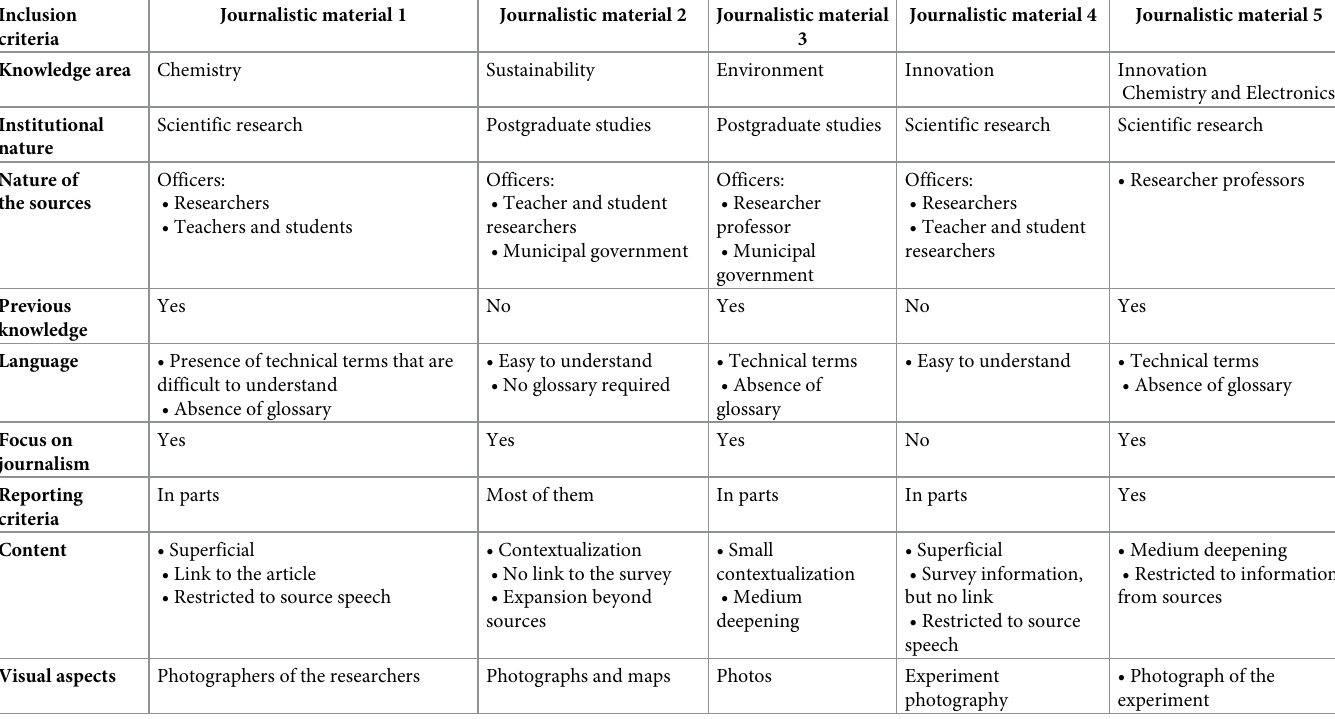
Table 2. Analysis of articles on research projects at one